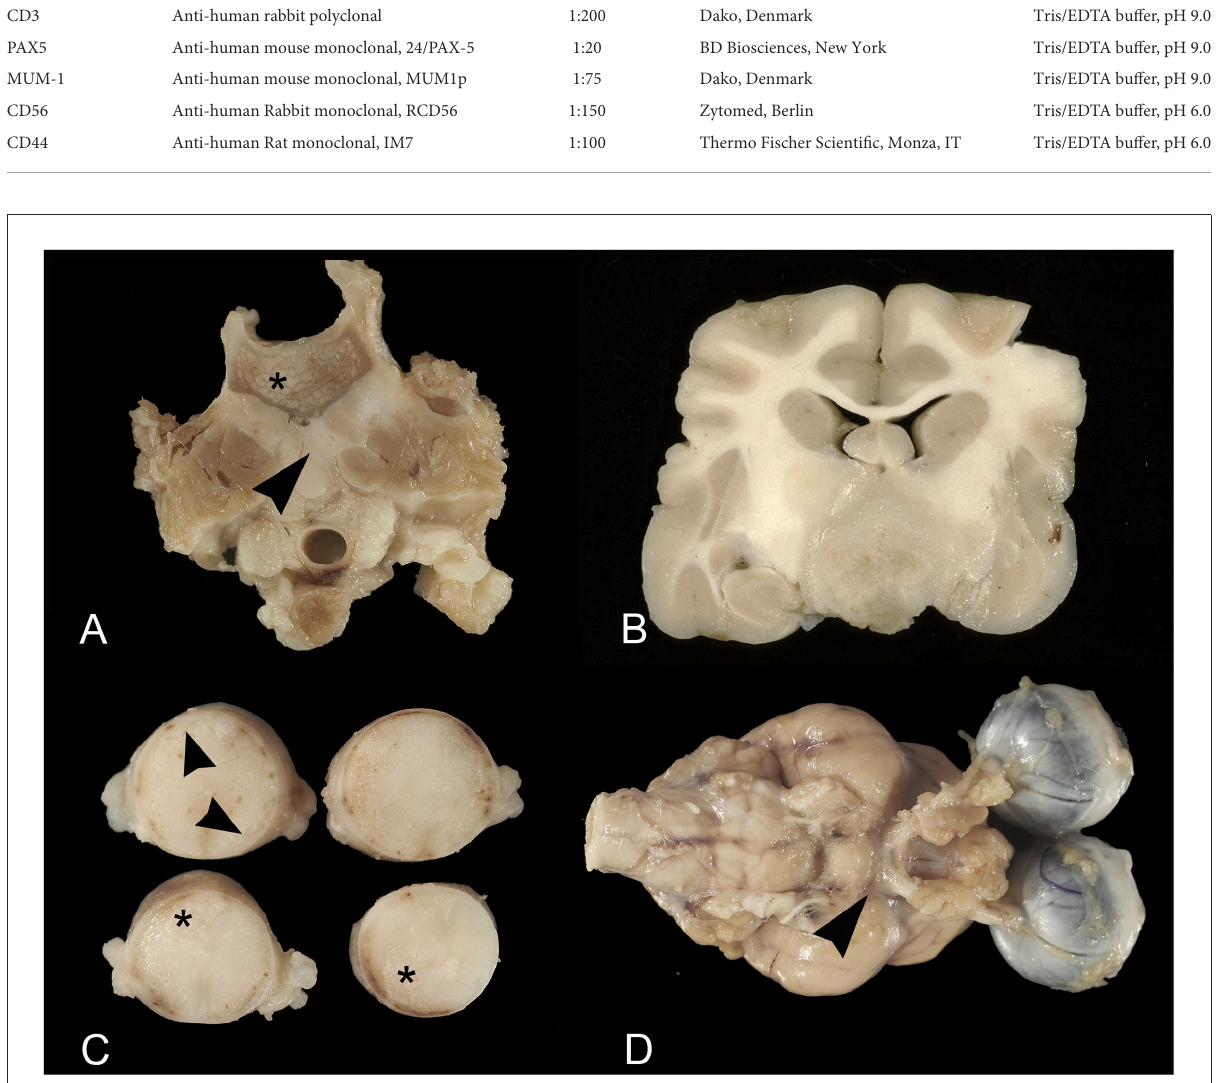
FIGURE1 Feline lymphoma of the nervous system. (A) Extra-axial lymphoma. Vertebral column at the level of L1. The vertebral body is partially replaced by lymphomatous tissue (asterisk) infiltrating the adjacent iliopsoas muscles (arrowhead); (B) Intra-axial lymphoma. Transverse brain section at the level of the rostral diencephalon. Intra-axial mass of whitish rather firm tissue, involving the brain base; (C) Leptomeningeal lymphomatosis. Thoracic spinal cord segments. Note the irregular leptomeningeal profile (arrowheads) and subpial parenchyma with large softening areas (asterisks); (D) Neurolymphomatosis and leptomeningeal lymphomatosis. Thickening of the optic nerves emerging from the optic chiasm and irregular leptomeningeal profile (arrowhead).